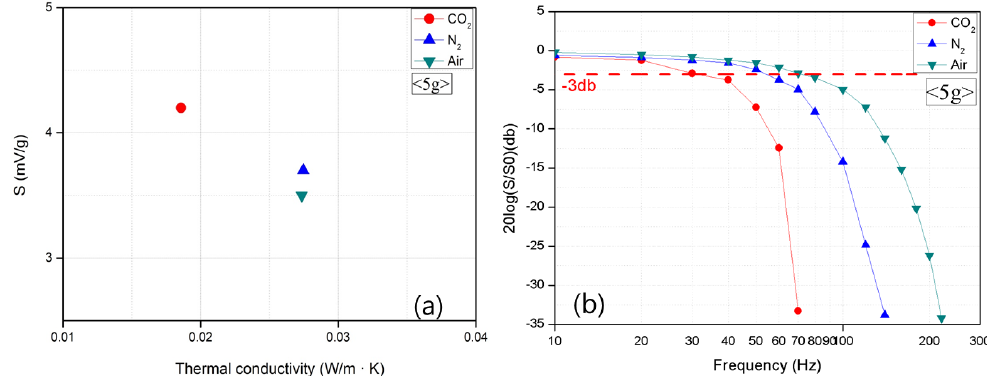
Figure 7. Output ( a ) sensitivity and ( b ) the frequency of the accelerometer according to gas medium.